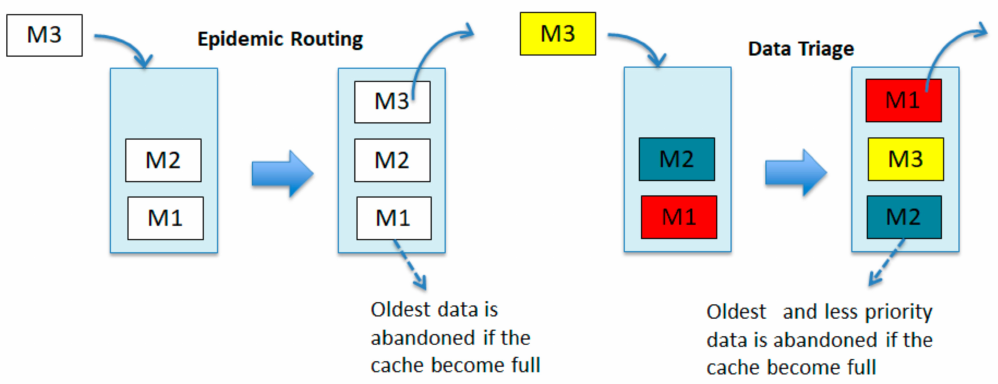
Figure 4. Queue rearrangements of the data triage. The left figure shows the FIFO (first-in first-out) type of queuing method that most DTN routing introduced. On the other hand, the right figure shows the proposed queuing methods that are rearranged based on the priority of the